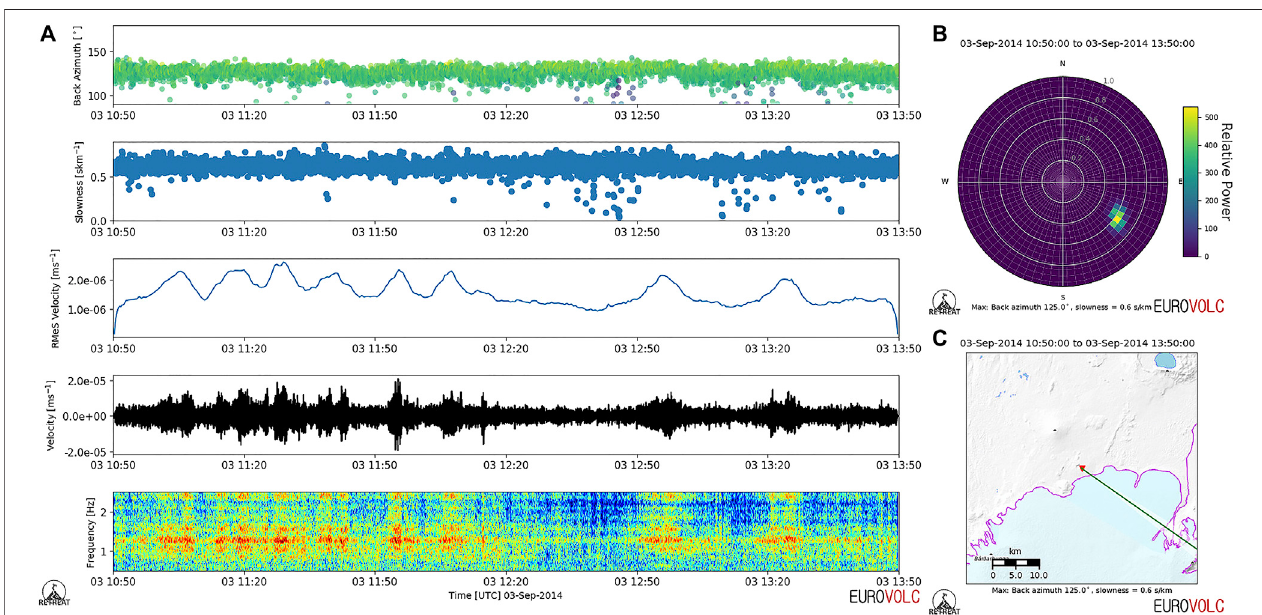
FIGURE 7 | Output fi gures produced by the RETREAT software for the archive data example. (A) Time series of slowness and backazimuth calculated from f-k analysis, alongside the seismic waveform, envelope and spectrogram and (B) apolar representation ofthe array processing results. Also shown is (C) amap ofthe area surrounding the UR array, with the resulting back azimuth overlaid, closely matching the results found by Eibl et al. (2017b).